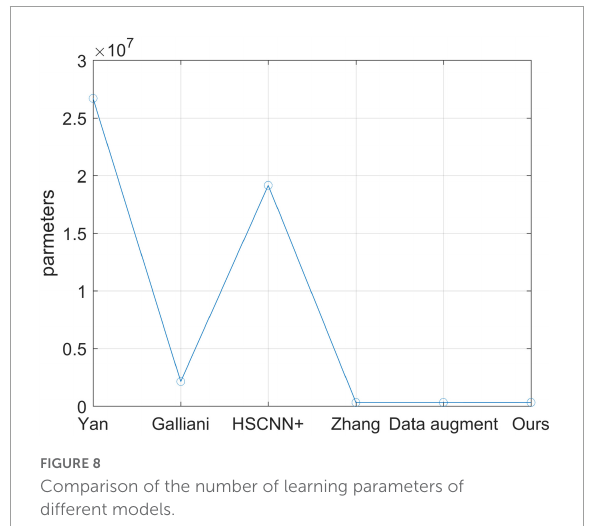
FIGURE8 Comparison of the number of learning parameters of different